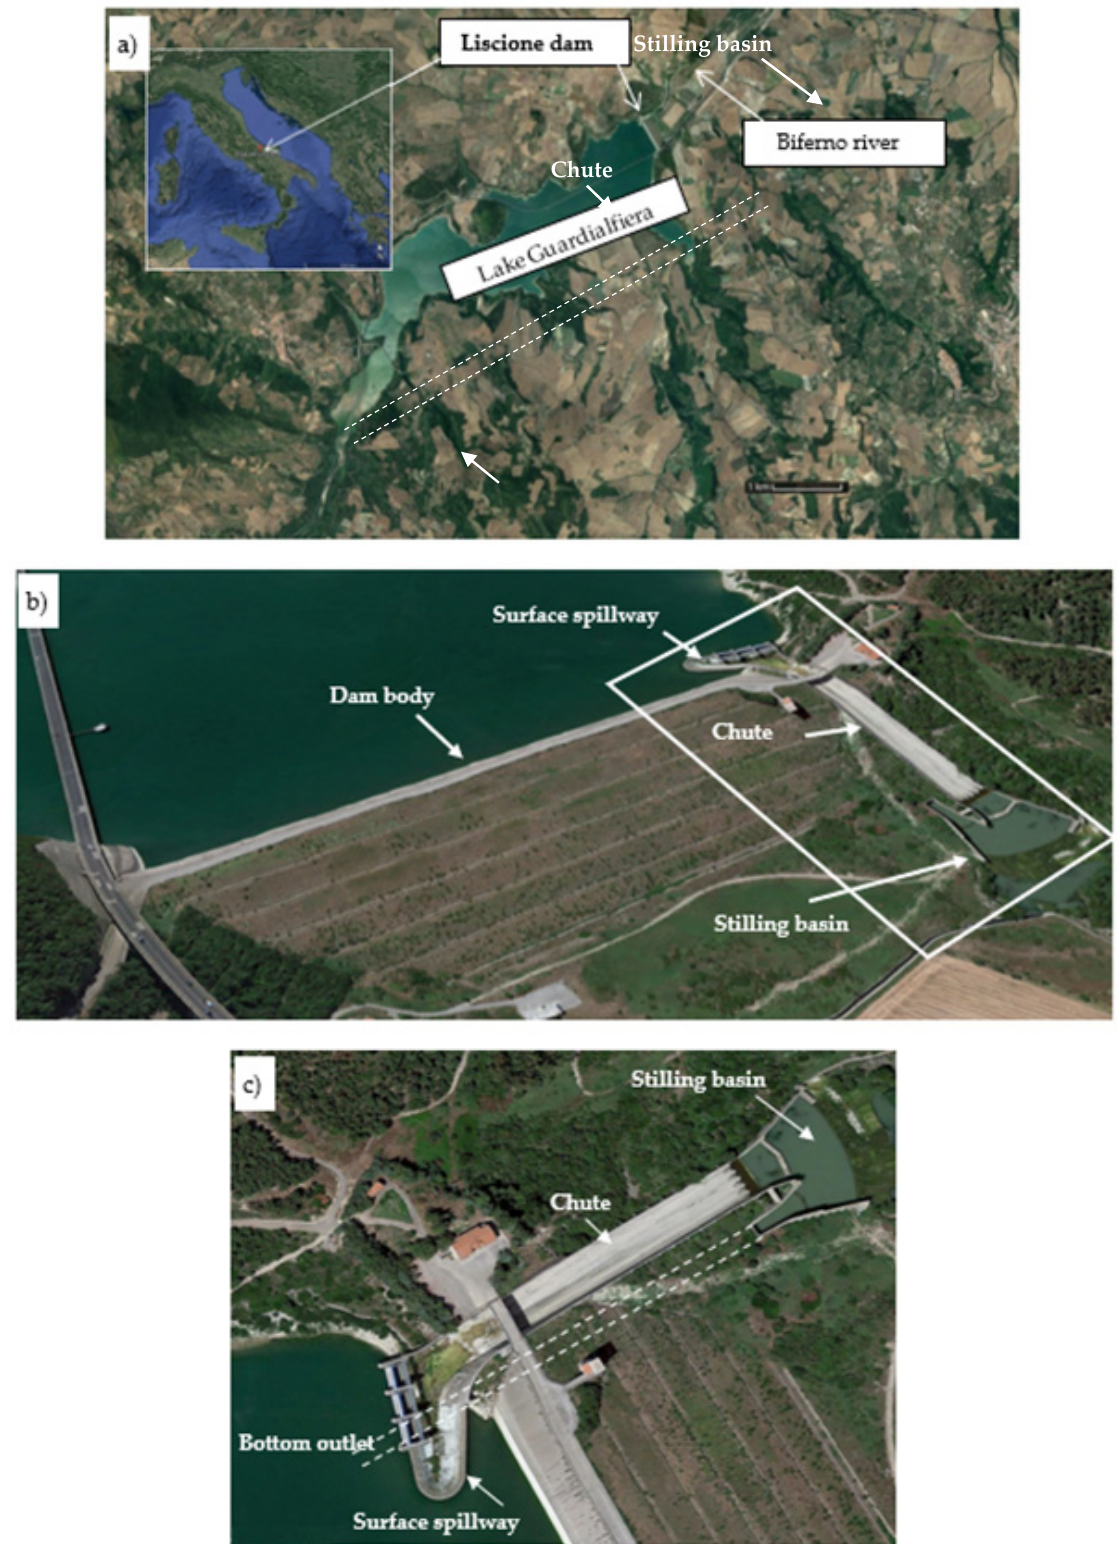
Figure 1. ( a ) The investigated area: geographical framework [Map data: Google]; ( b ) overview of the dam body and main elements; ( c ) detailed view of the main elements of the dam, i.e., surface spillway, chute, stilling basin and bottom outlet.